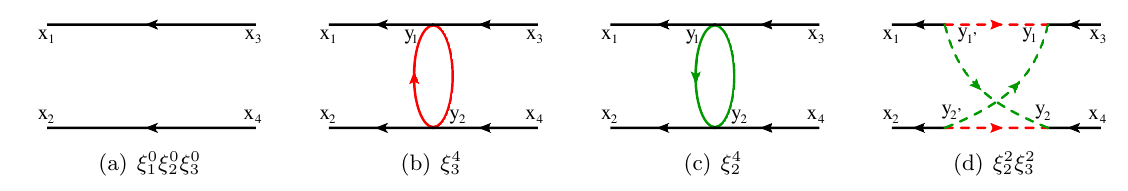
Figure 10 . First contribution to the four-point functions G (cid:30)